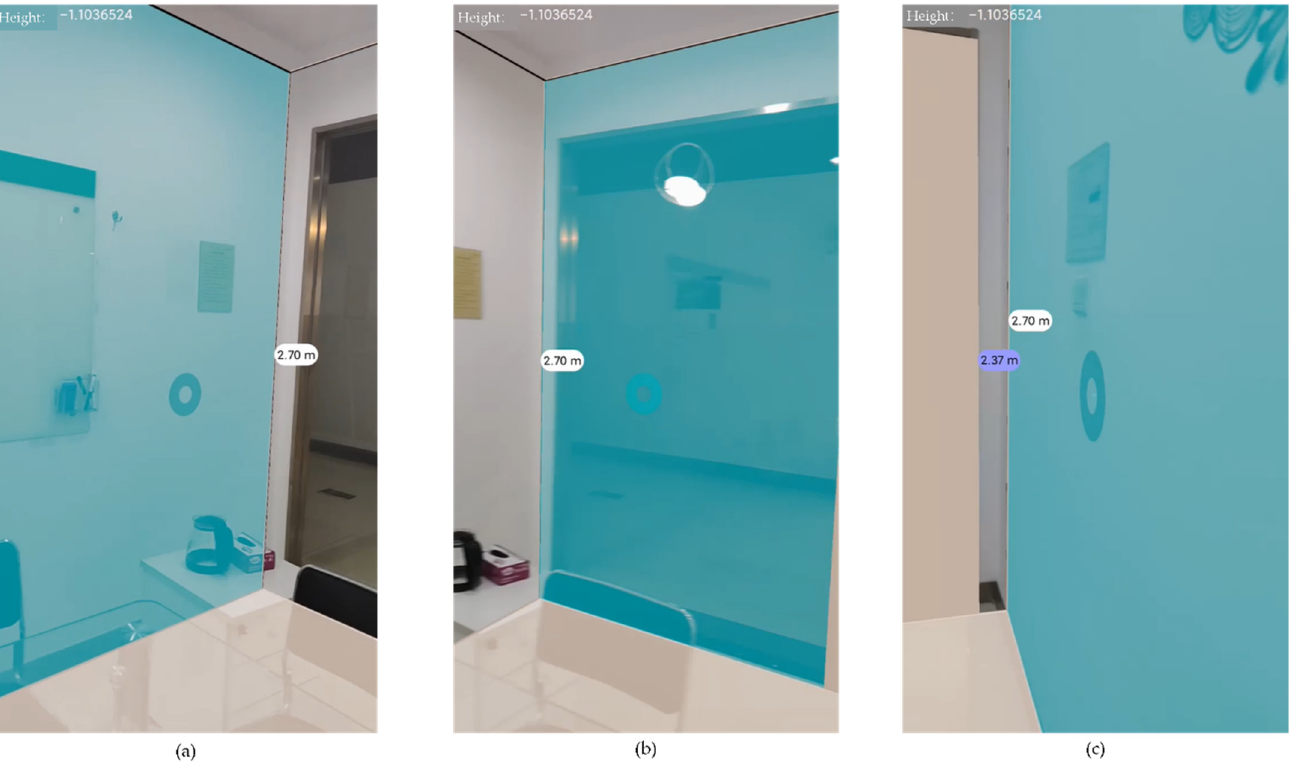
Figure 5. Real-time capture results of the camera’s six degrees of freedom (6-DOF) positions on different vertical planes: ( a ) 6-DOF projection points in vertical plane a; ( b ) 6-DOF projection points in vertical plane b; ( c ) 6-DOF projection points in vertical plane c.